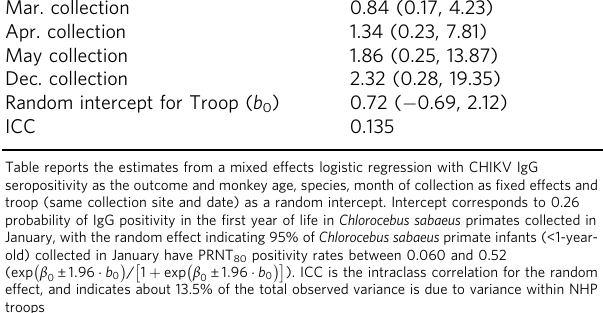
Table reports the estimates from a mixed effects logistic regression with CHIKV IgG seropositivity as the outcome and monkey age, species, month of collection as fi xed effects and troop (same collection site and date) as a random intercept. Intercept corresponds to 0.26 probability of IgG positivity in the fi rst year of life in Chlorocebus sabaeus primates collected